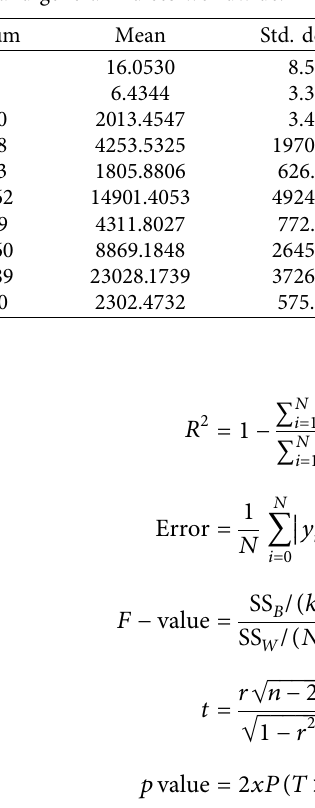
Table 2: Statistical description of date and general indices